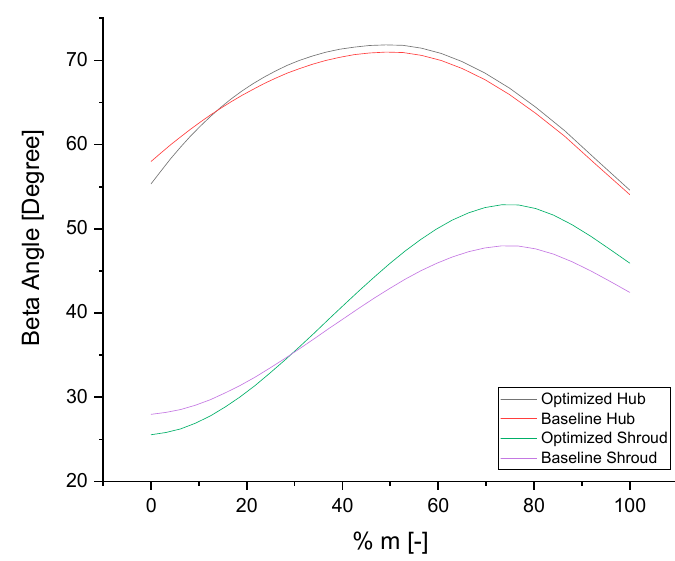
Figure 14. Beta distribution comparison between the optimal and baseline impellers.